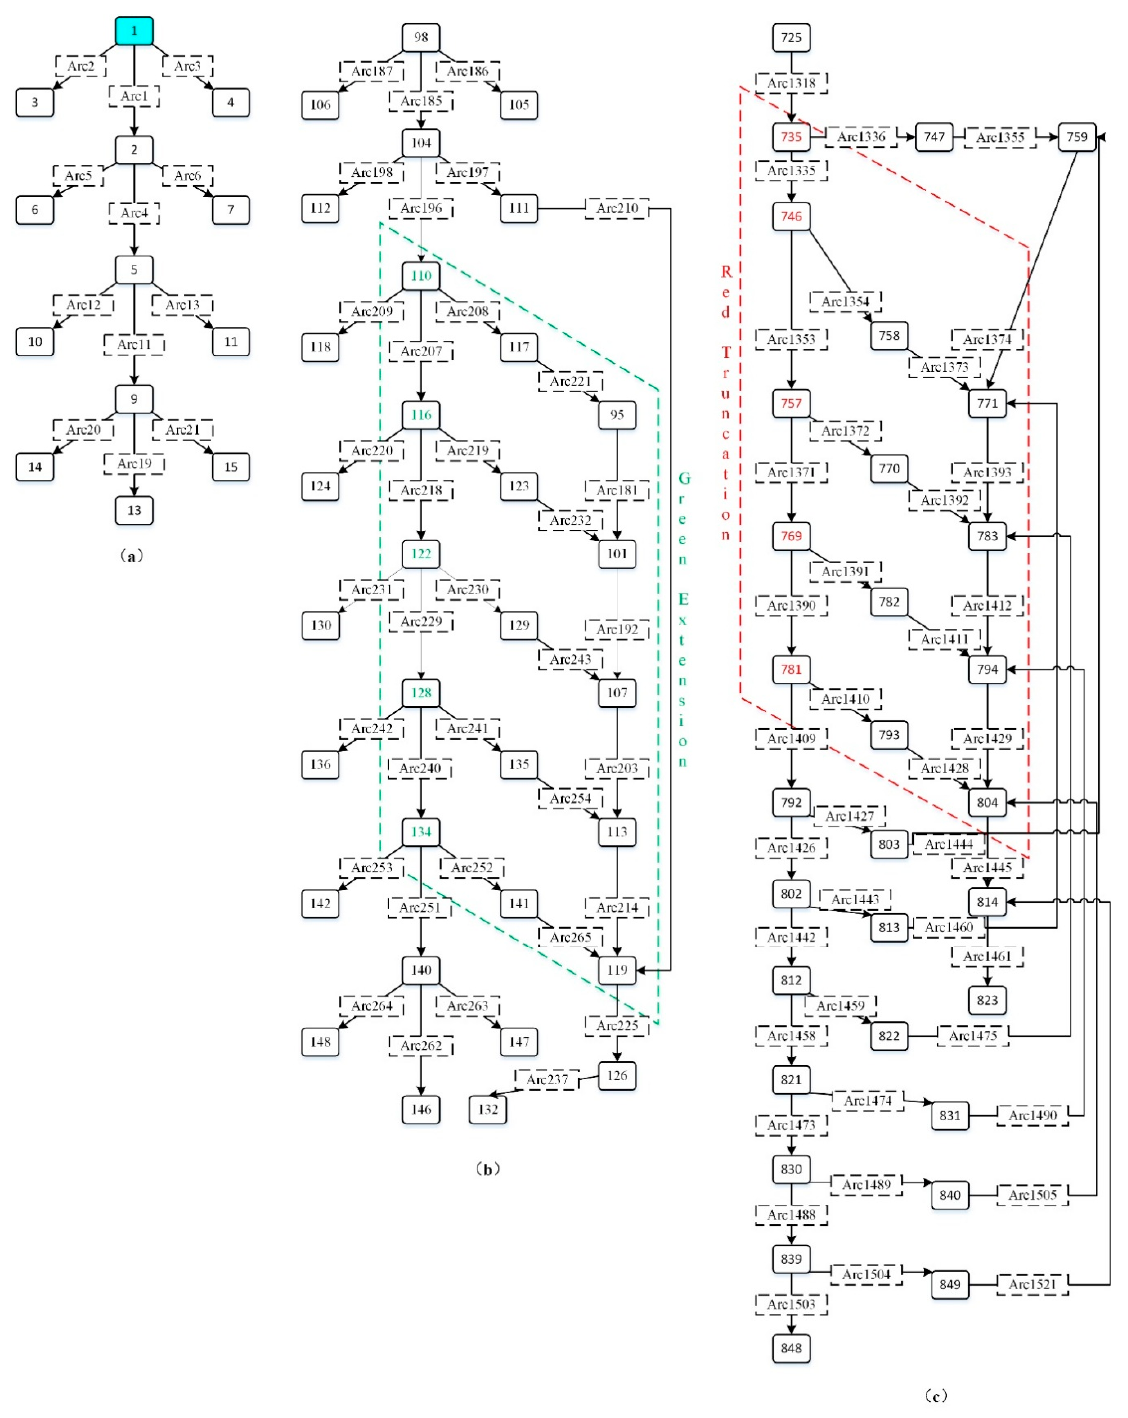
Figure 4. Partial state spaces of the transit signal priority control HCPN model.